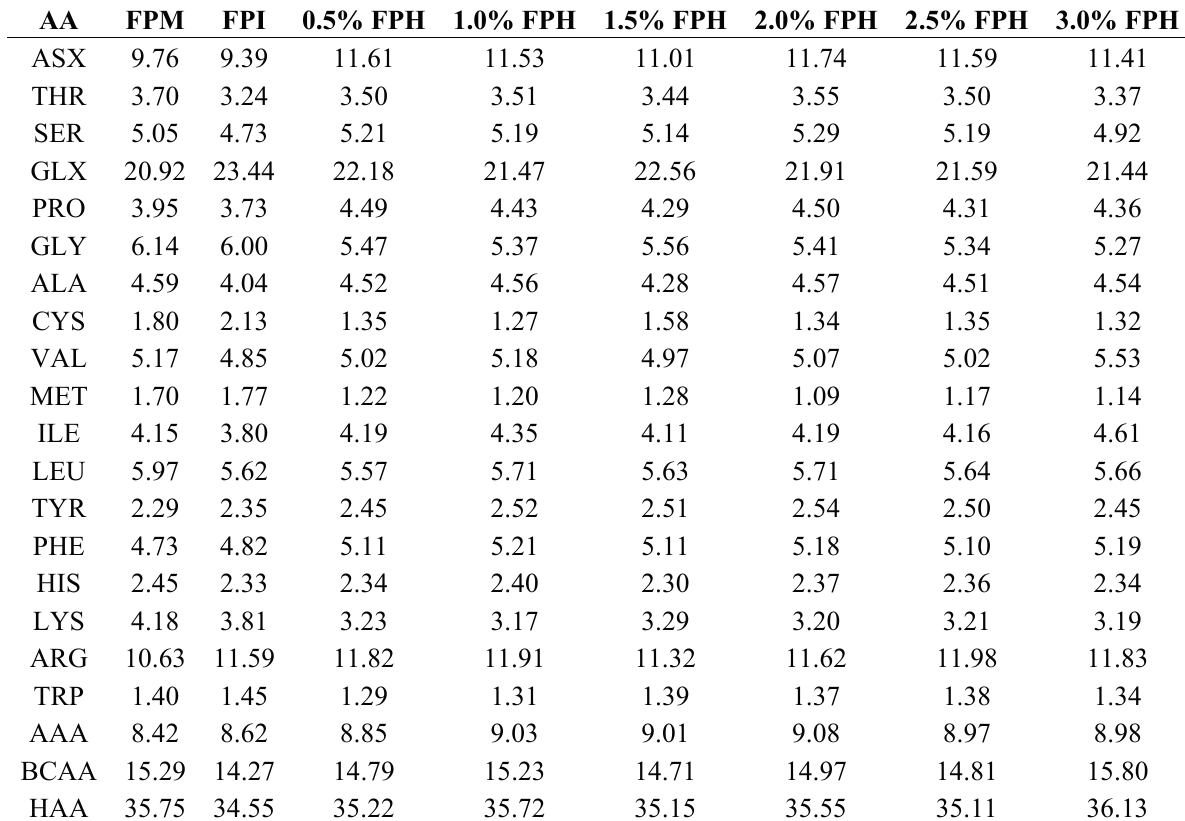
Table 1. Percentage amino acid (AA) compositions of flaxseed protein meal (FPM), isolate (FPI), and hydrolysates (FPH) samples digested at different thermoase-GL 30 concentrations